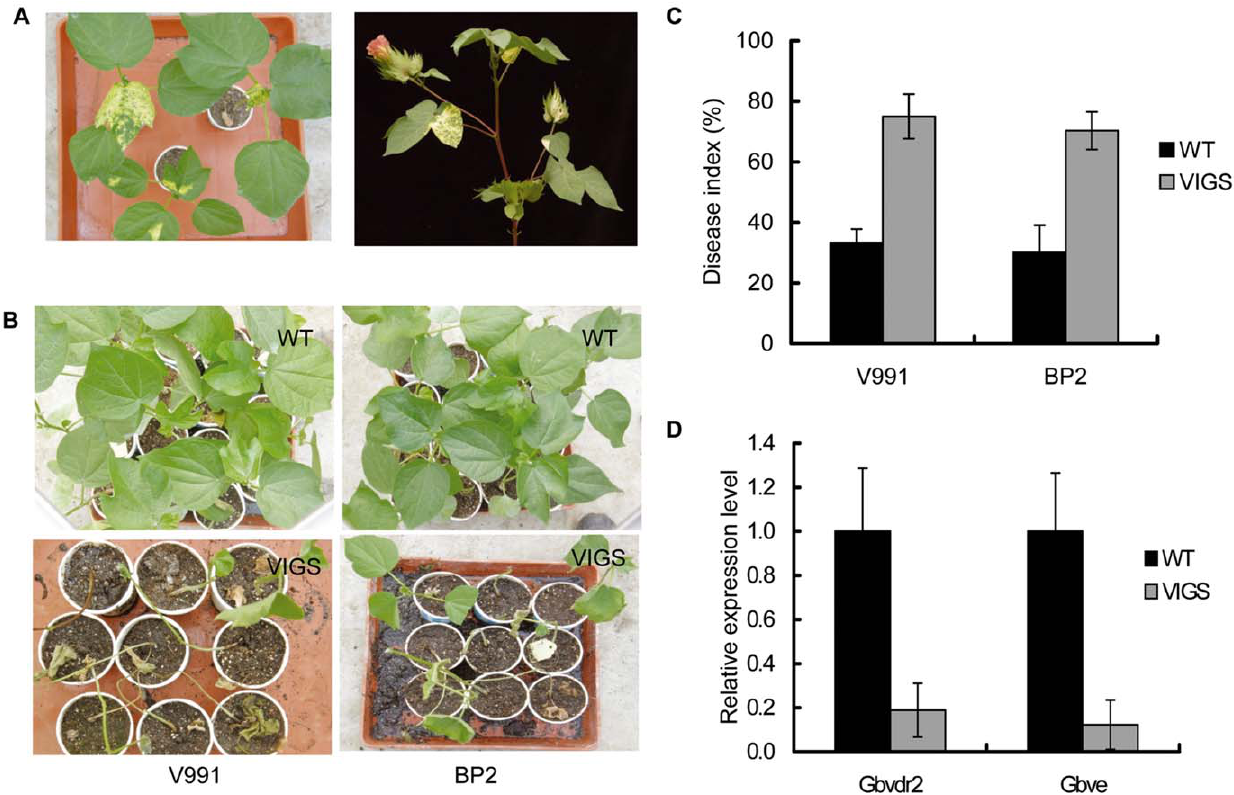
Figure 4. The Gbve1 gene endowed Verticillium wilt resistance in cotton. (A). The cotton chlI gene was used as a positive control with a phenotype of yellow-colored leave after VIGS in cotton (Left: 3 weeks; Right: blossom stage). (B). The phenotypes of H7124 under infection by V. dahliae isolates V991 and BP2 after VIGS with CLCrV containing a fragment of Gbve1 gene. Photos were taken at 42 d after V. dahliae inoculation (55 d after VIGS). (C). The disease indices Gbve1 gene-silence lines. The results were presented as means 6 SE from three replications with at least 25 plants per replication. (D). Expression levels of the Gbve1 gene and its homolog (the Gbve gene) in the silenced lines.